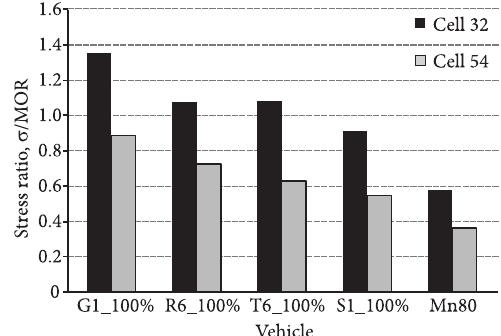
Fig. 10. Fatigue damage (stress ratio) comparisons for examined test